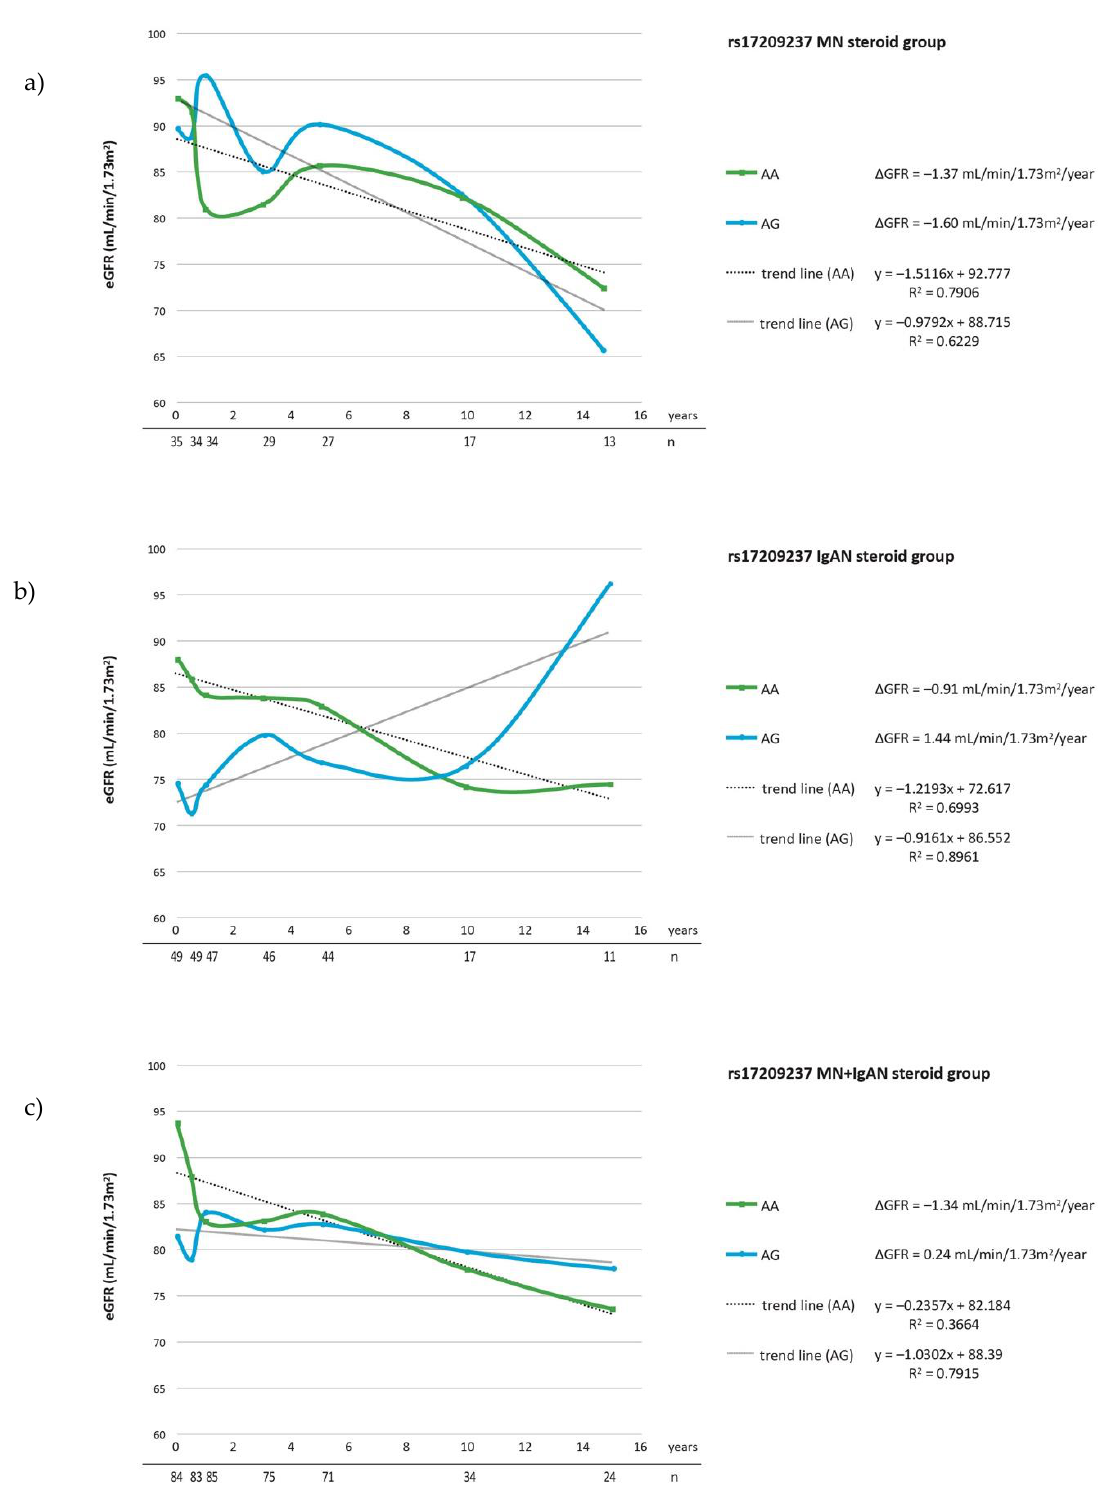
Figure 4. ΔeGFR for rs17209237 genotypes during follow-up period in ( a ) MN patients treated with steroids; ( b ) IgAN patients treated with steorids; ( c ) MN + IgAN patients treated with steroids. Number of patients are expressed as ( n ).